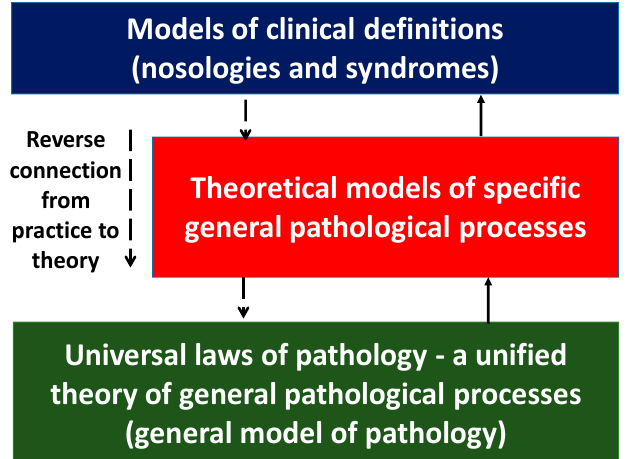
Figure 8. Conceptual relationships between theoretical and clinical definitions.